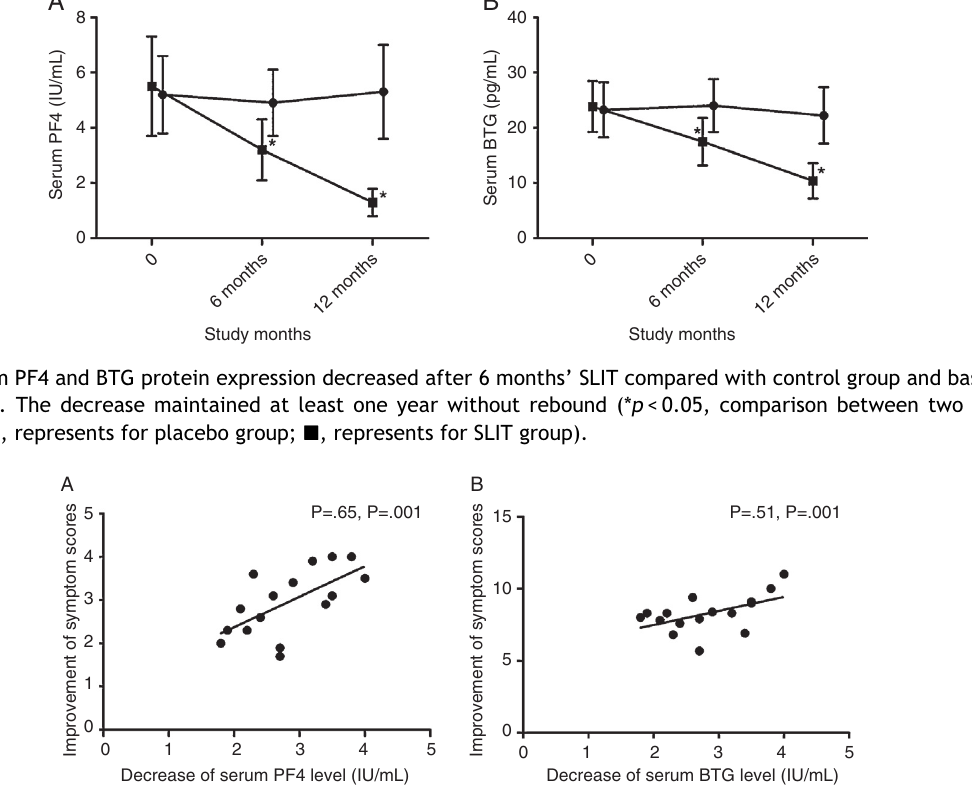
Figure 2 Positive relationship between improvement of symptom scores and decrease of serum PF4 and BTG protein levels of children after one year’s SLIT in active treatment group (A and B). asthma patients undergoing bronchial allergen